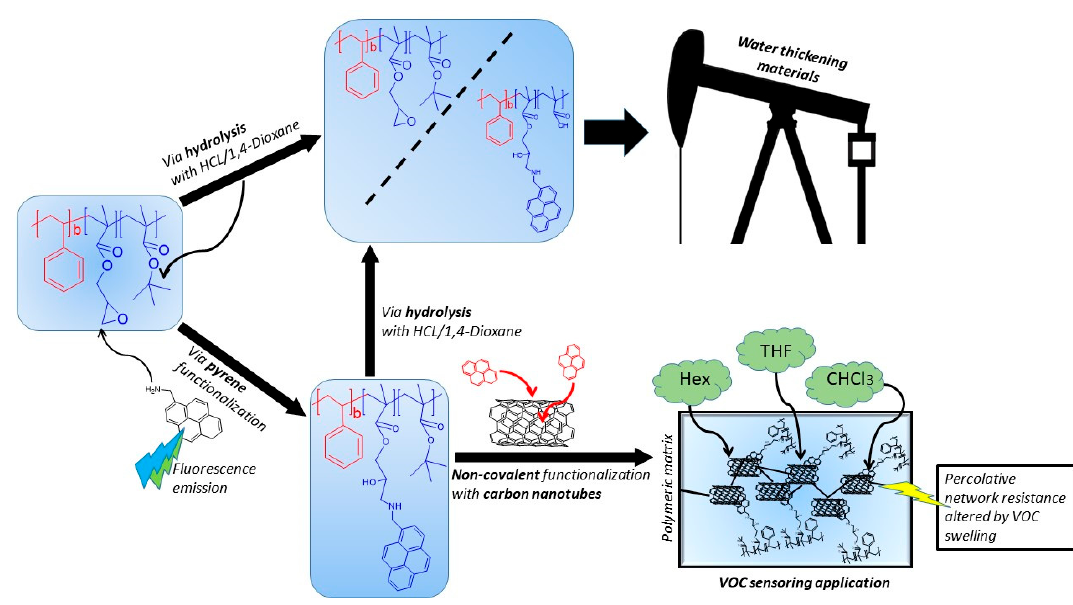
Scheme 1. Visual representation of the versatility of the synthesized